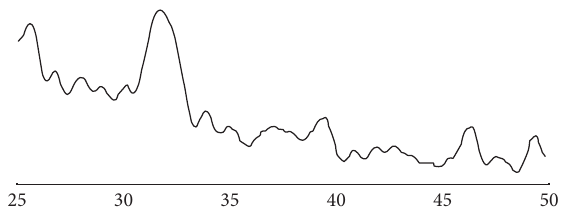
with pH � 7.87, T � 40 ° C, and D � 1h. 2